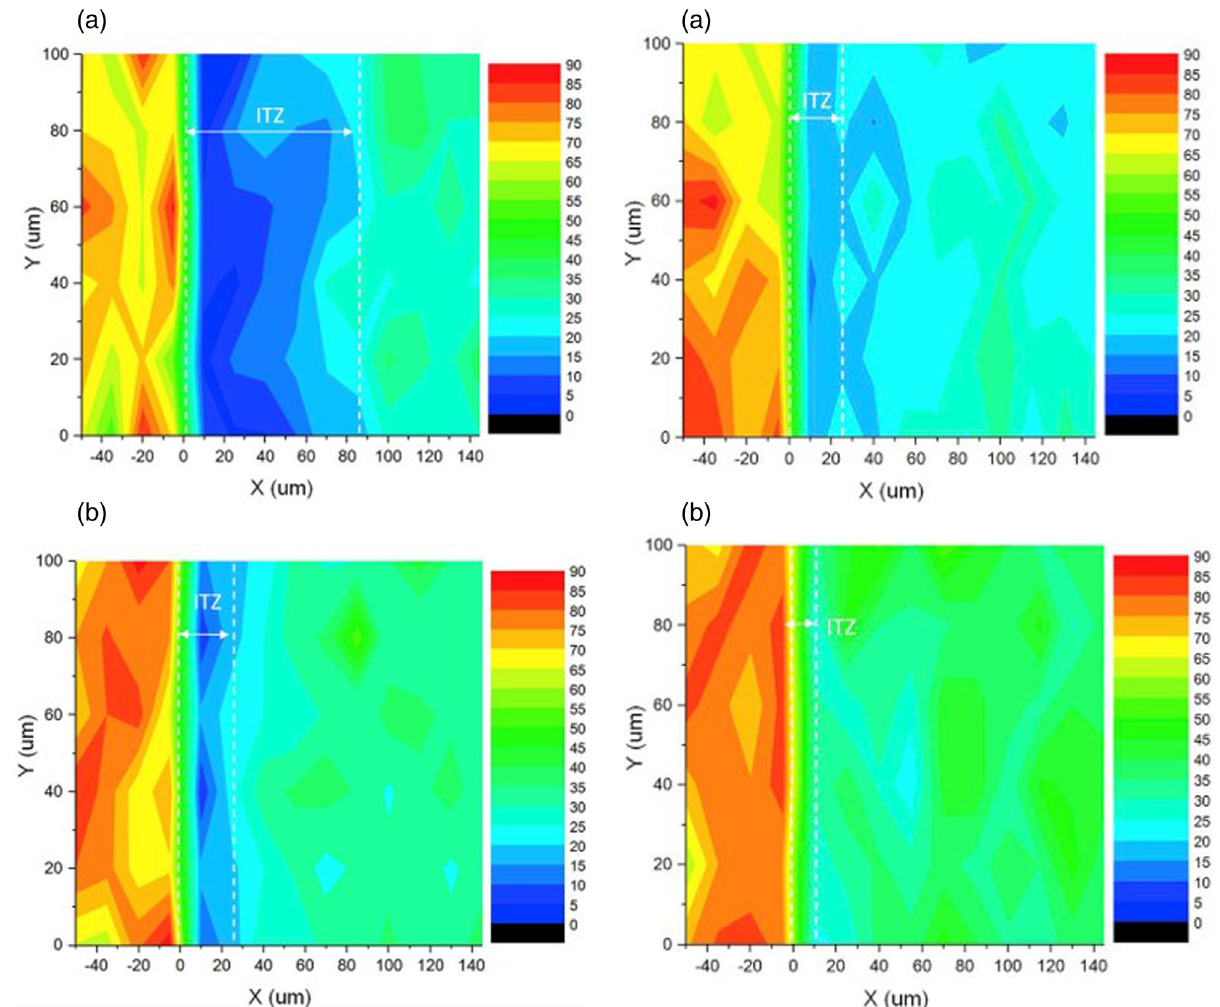
Figure 8: Counter map of indentation modulus ( the w/c ratios of a and b are 0.45 and 0.35, respectively, and the right side is modi fi ed by adding silica fume ) [ 85 ]